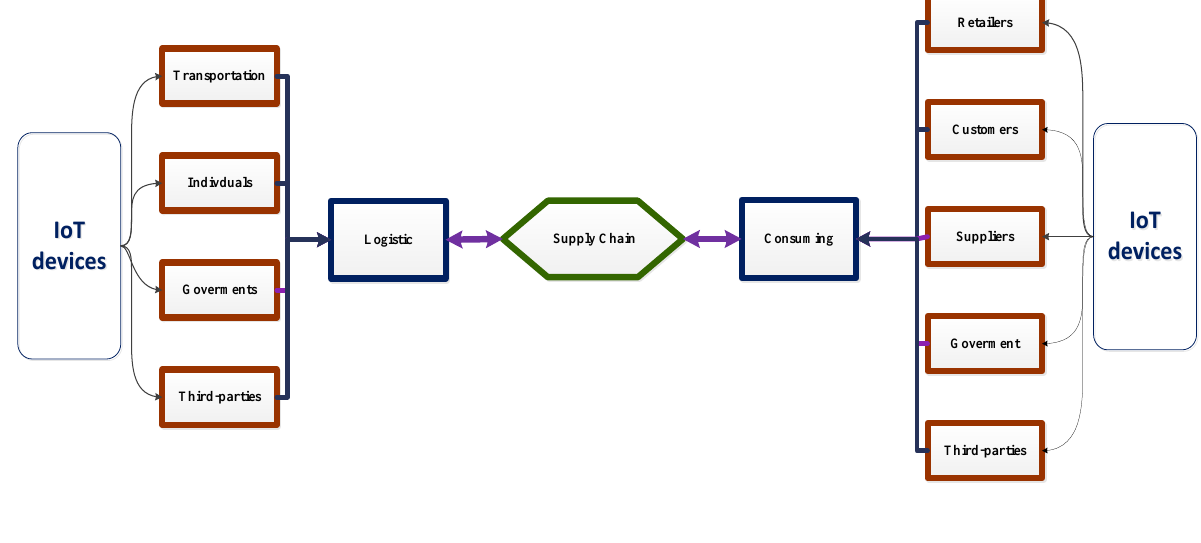
Figure 3. Big data sources in the supply